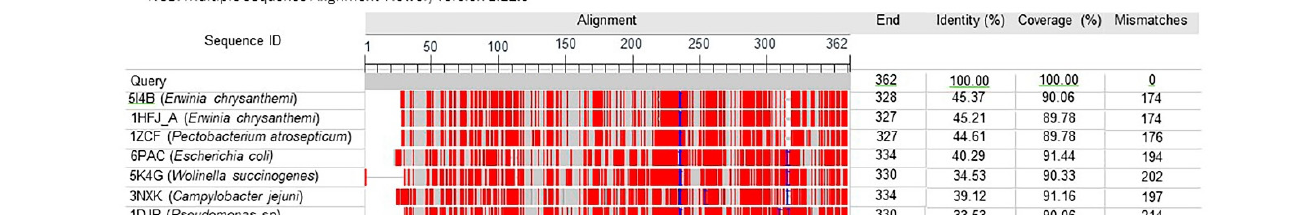
Figure 1. Hinge Region (HR), Active Site Flexible Loop (ASFL) and active site residues alignment. ( a ) Alignment of the most similar Protein Data Banks’s (PDBs) sequences. HR is indicated in brown, ASFL in blue and the residues relevant to the catalytic activity are highlighted in green. ( b ) Different views of the flexible region of the L ‐ asparaginases (ASPases) aligned as in ( a ). All sequences include the correspondent alignment to the region GLY40:VAL70 of the P. sizovae ASPase model. In orange, the most different structure, the PDB 5K4G “open/inactive” form of Wolinella succinogenes ASPase. Chains: P. sizovae (black); Pseudomonas sp. (light green, PDB 1DJP); Wolinella succinogenes “closed/active” form (red, PDB 5K3O); Campylobacter jejuni (brown, PDB 3NXK); Erwinia crysanthemi (pink and light blue, PDBs 1HFJ and 5I4B); Pectobacterium ( Erwinia ) carotovora (yellow and green, PDBs 1ZCF and 2GVN). ( c ) Identity percentage and full alignment residue differences (in red) among the compared asparaginases.